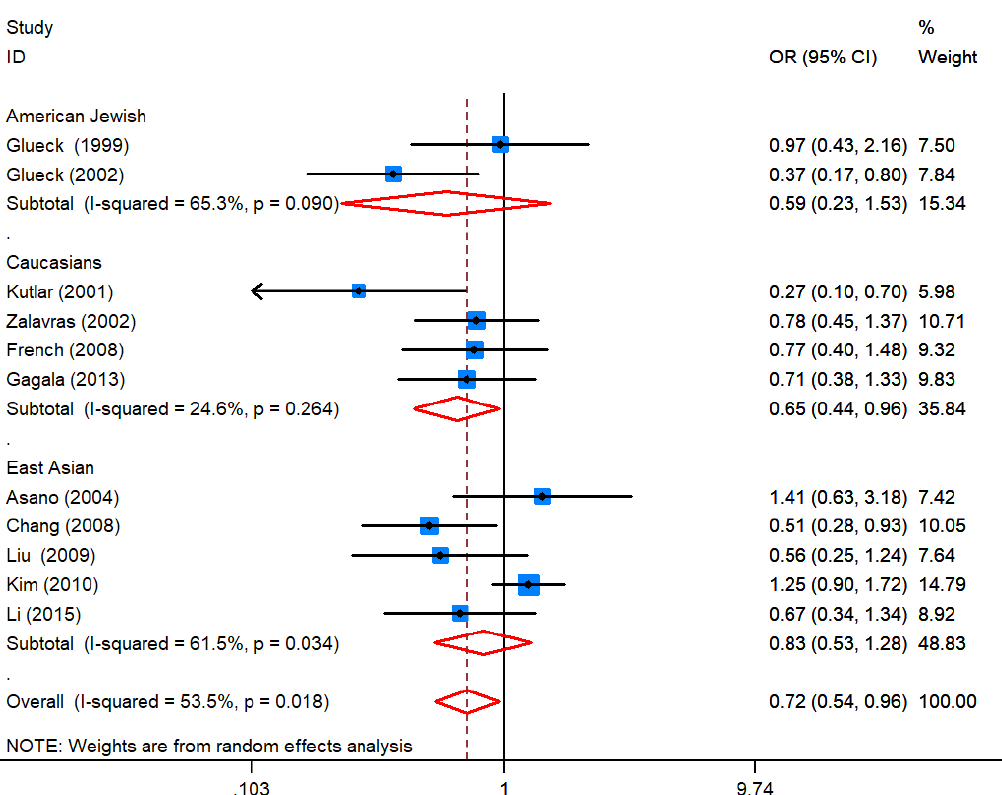
Figure 3. Subgroup analysis (American Jewish, Caucasians and East Asian ) of the forest plot of OR for MTHFR C677T polymorphism and non- traumatic osteonecrosis of the femoral head(CC vs